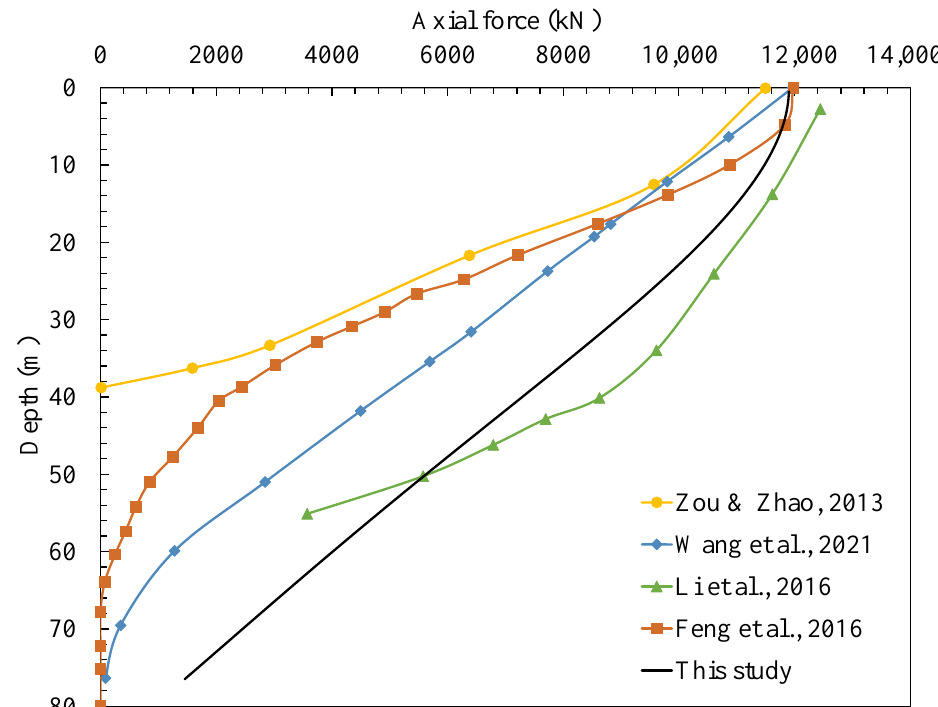
Figure 14. Comparison of the axial force distribution along the pile with the results from other tests [22 – 25].